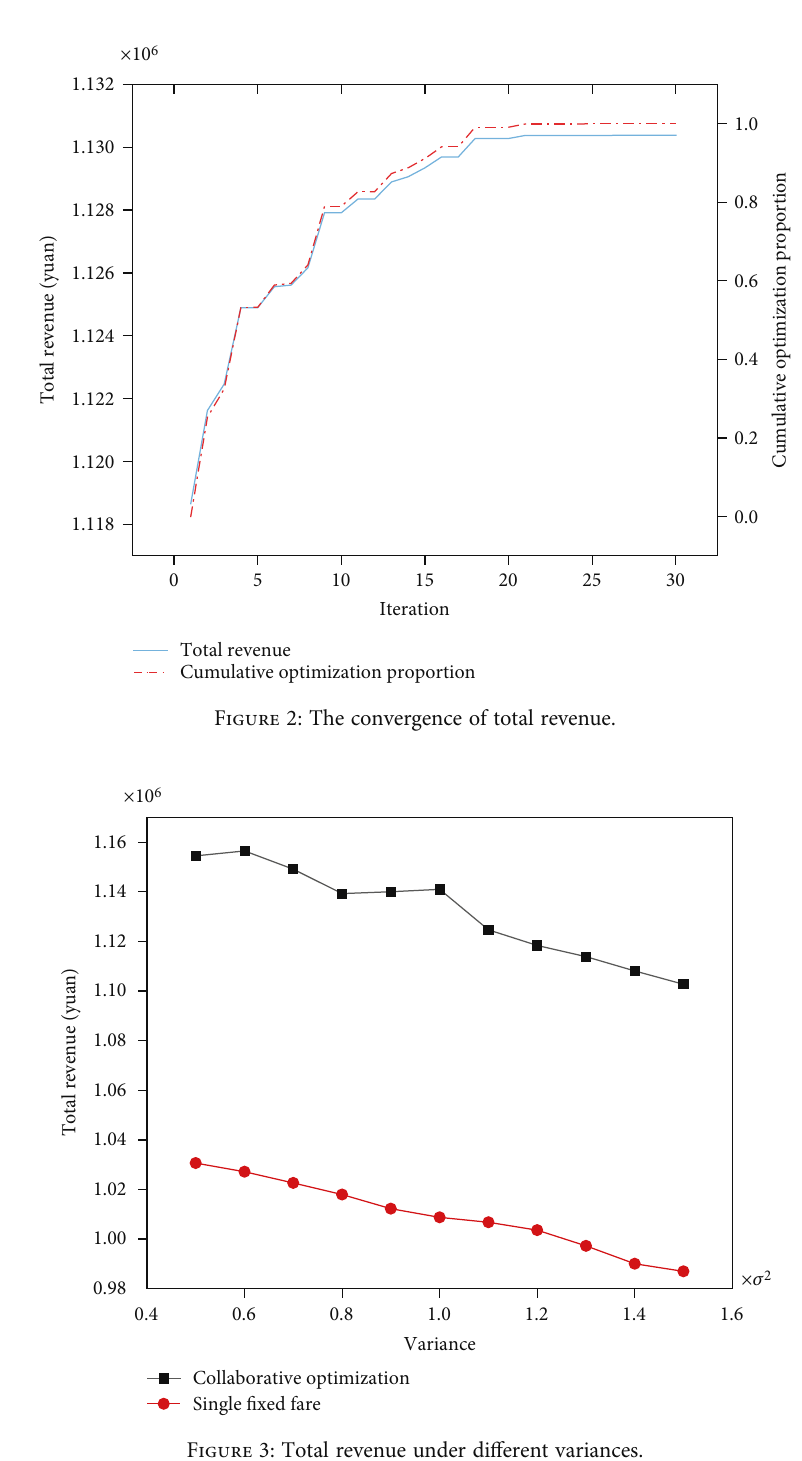
Figure 3: Total revenue under di ff erent